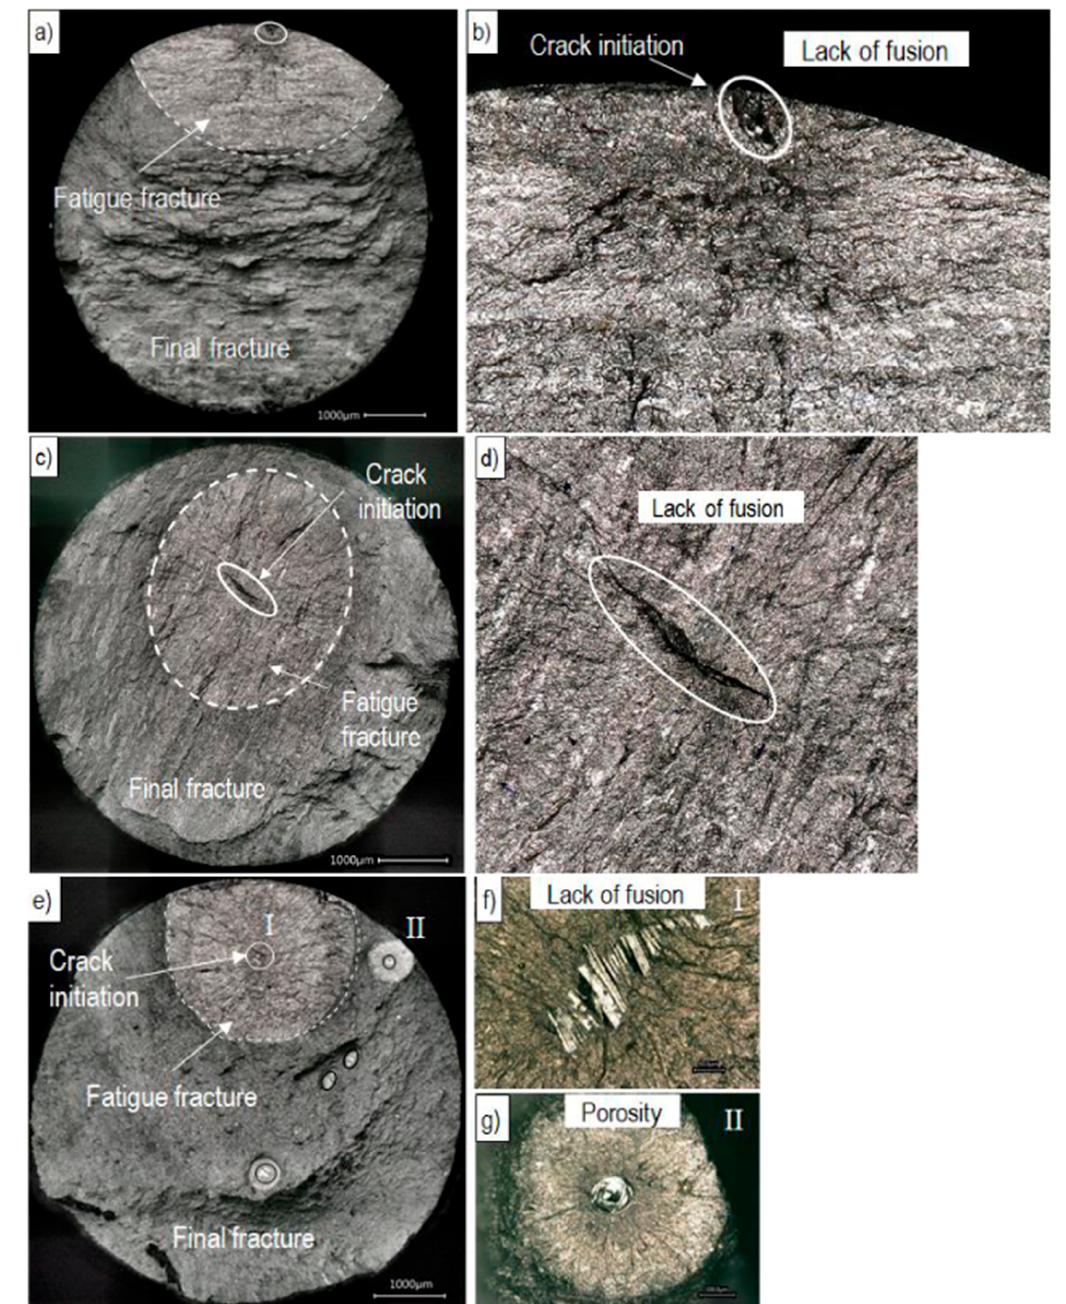
Figure 11. Comparison of fatigue fracture surfaces of EBM manufactured Ti-6Al-4V samples produced in ( a )–( d ) horizontally and ( e )–( g ) vertically build direction. The defects are shown in higher magnification on the right side.